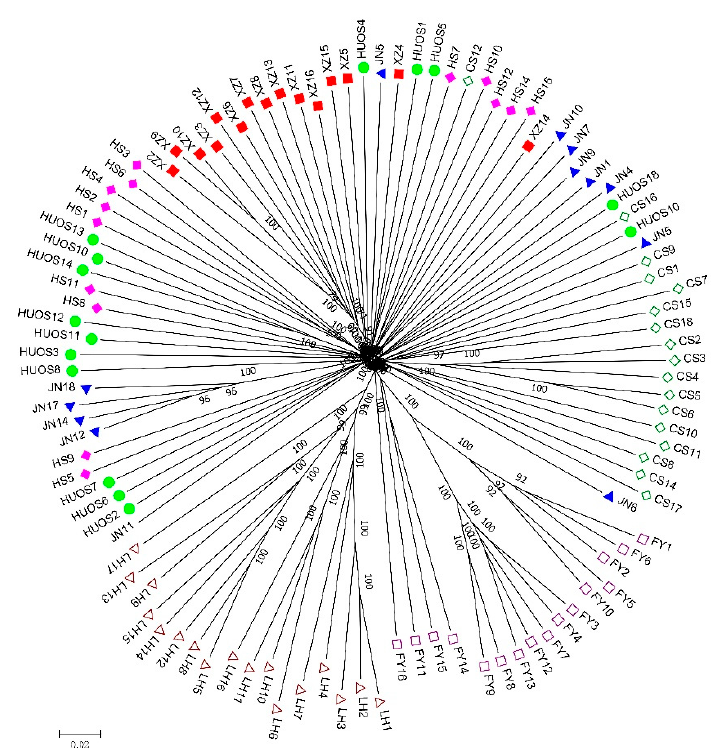
Figure 2. Phylogenetic tree of the 197 individuals based on the analysis of 457,888 single nucleotide polymorphisms (SNPs).